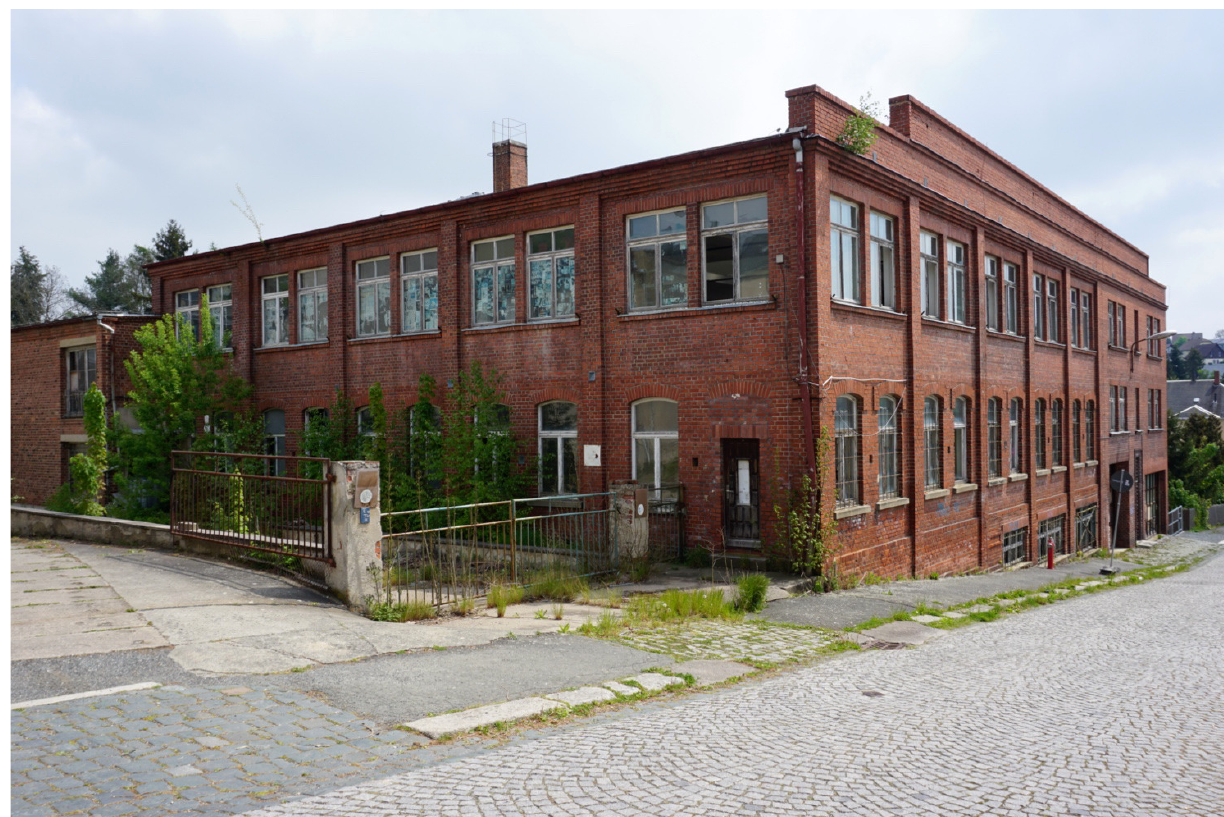
Figure 2. To various vacant industrial buildings like this former textile mill in Pausa, Saxony, an “eyesore” narrative is attributed